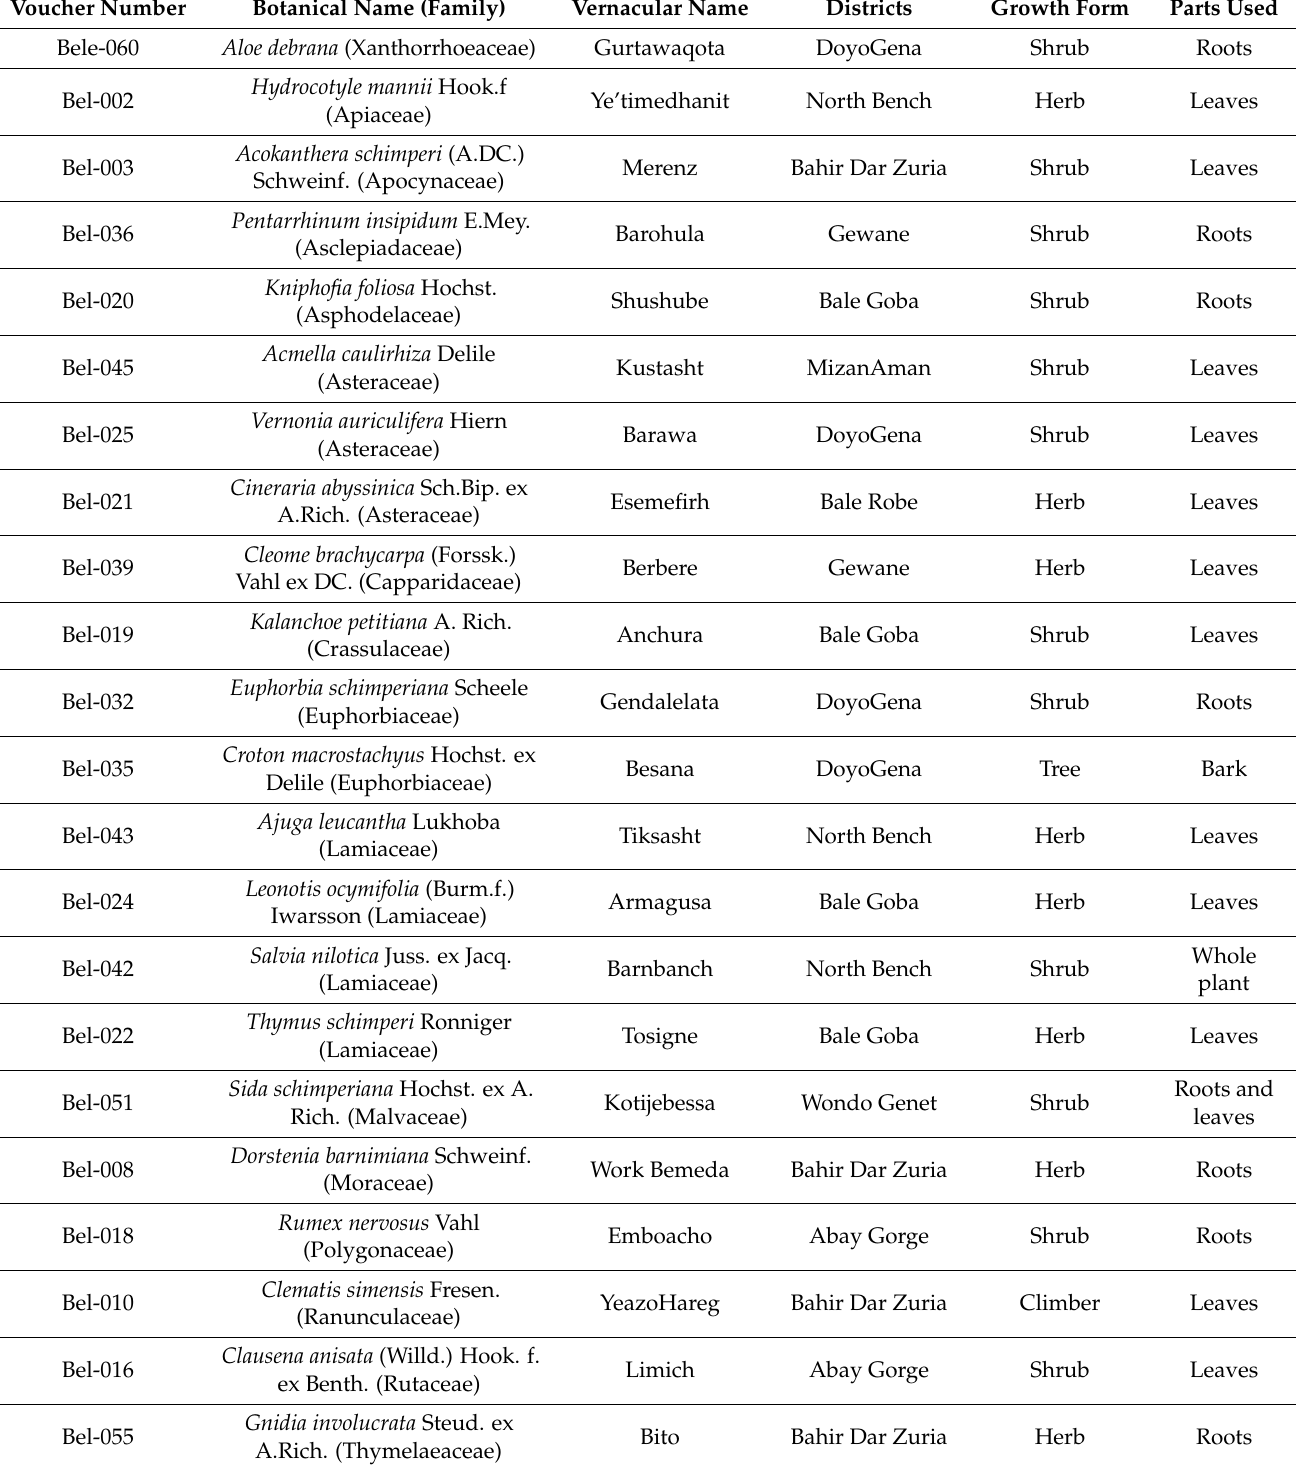
Table 3. List of 22 medicinal plants traditionally used to treat different human ailments in the study areas. Voucher